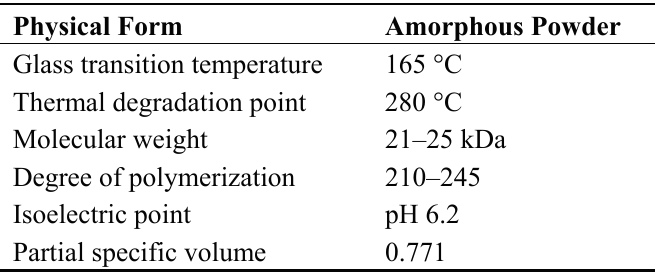
Table 1. General properties of α -zein a